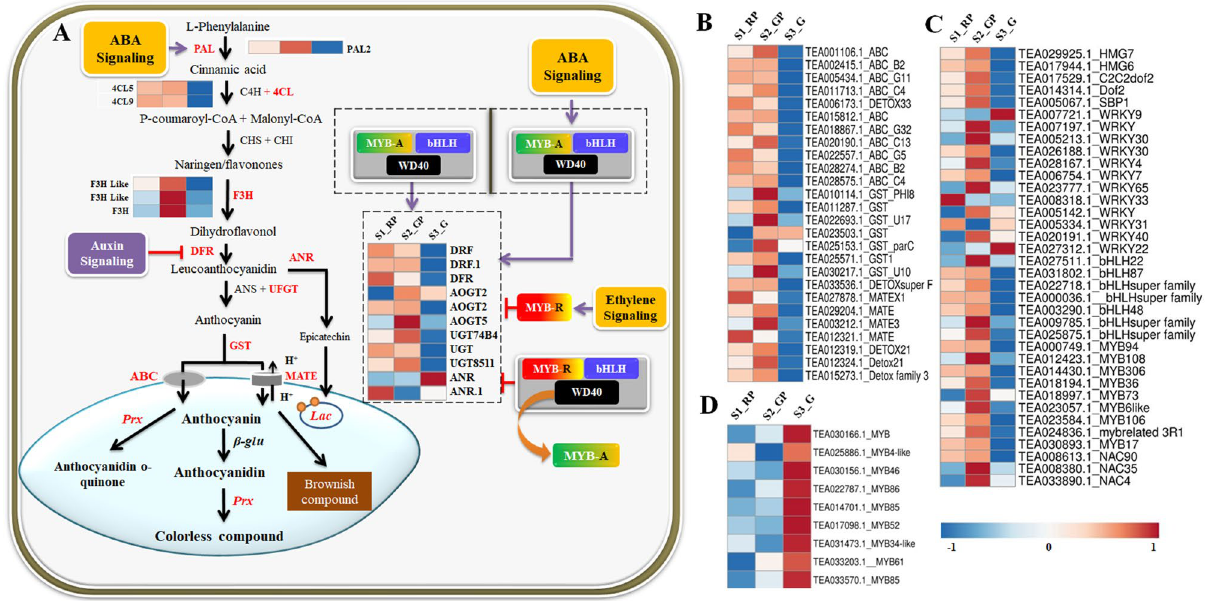
Figure 4. ( A ) Anthocyanin biosynthesis pathway. Highlighted genes (red) represent differentially expressed genes of the pathway. Purple pointed arrows represent activation, curved right arrow represent displacement while red bar-headed arrows represent inhibition. ( B ) Heatmap of differentially expressed transporters. ( C ) Transcription factors associated with anthocyanin biosynthesis in tea. ( D ) Putative repressor MYBs. Blue and red colors of heatmaps represent upregulated and downregulated expression levels, respectively. The color scale reflects log2 transformed FPKM